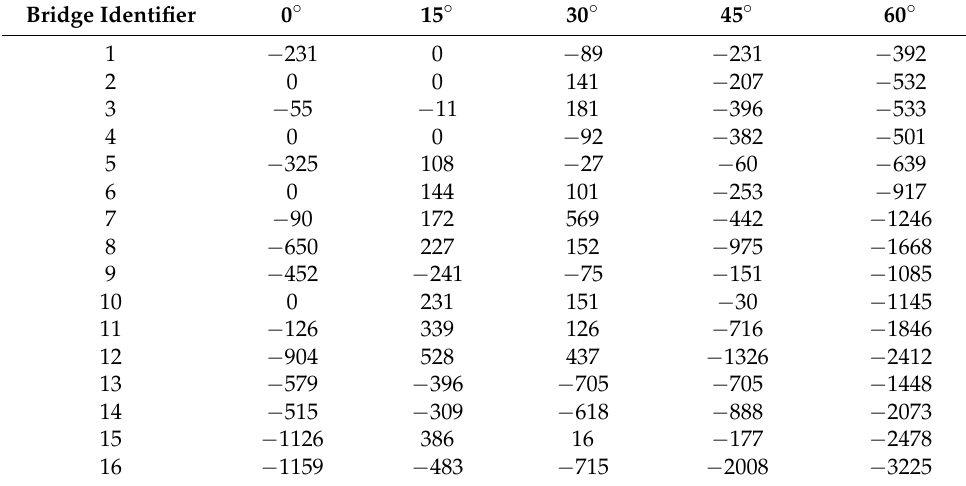
Table 10. Difference (in kg) between total weight of reinforcement determined with LFEA and AASHTO LRFD. The difference is determined as the amount of steel designed using LFEA minus the amount required by AASHTO LRFD. Bridge identifiers are explained in Table 7.